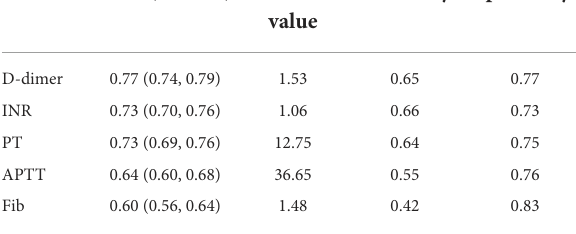
TABLE 3 Performance of variables in predicting in-hospital mortality. Variable AUC (95% CI) Cut-off